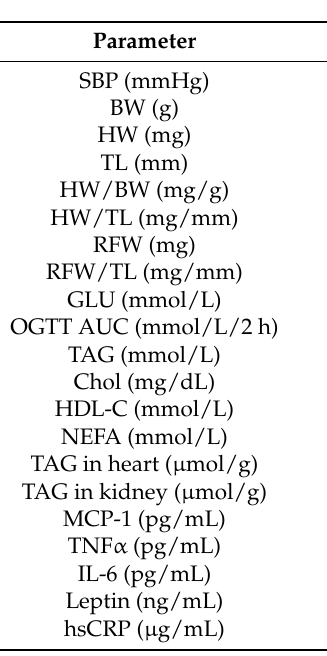
Table 1. General characteristics of experimental